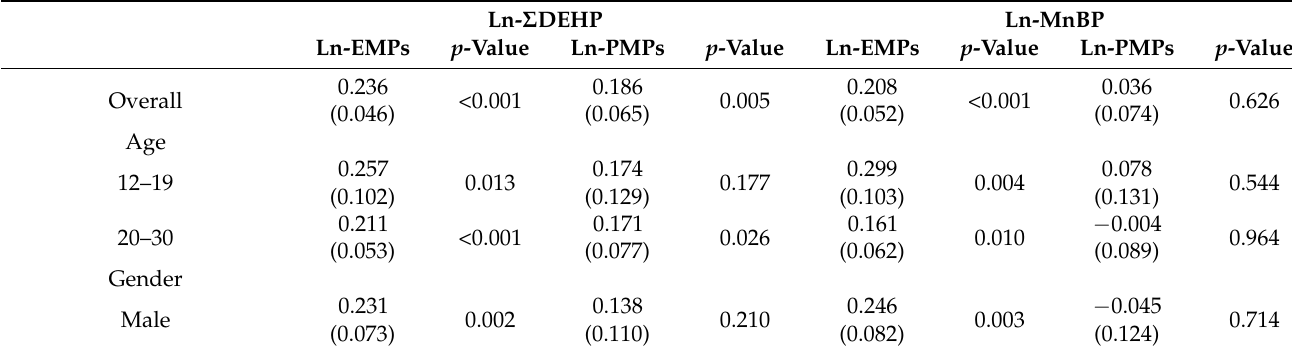
Table 2. Linear regression coefficients (standard error) of natural log-transformed endothelial microparticles (EMPs) and platelet microparticles (PMPs) with per unit increase in natural log-transformed Σ DEHP and MnBP in multiple linear regression model a for overall and subgroup